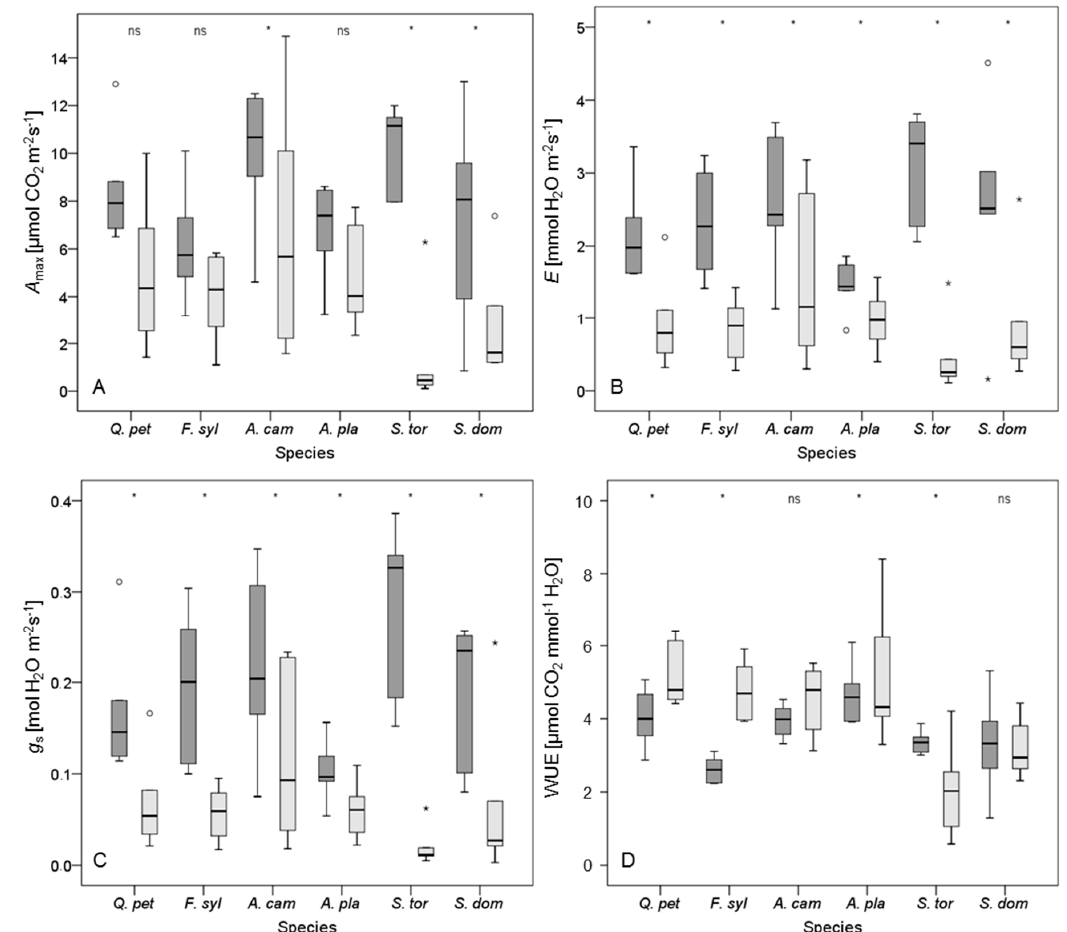
Figure 3. Box plots for ( A ) maximum photosynthetic rate ( A max ); ( B ) transpiration rate ( E ); ( C ) stomatal conductance to water vapor ( g s ); and ( D ) water use efficiency (WUE ( A max / E )) for plants of the control (dark grey box plots) and the dry group (light grey box plots) after 32 days without irrigation. Species are abbreviated as Q. pet ( Quercus petraea ), F. syl ( Fagus sylvatica ), A. cam ( Acer campestre ), A. pla ( A. platanoides ), S. tor ( Sorbus torminalis ), and S. dom ( S. domestica ). Empty circles denote outliers (defined as 1.5–3 times of box height), small stars represent extreme values (defined as more than 3 times of box height). Asterisks indicate significant differences between irrigation regimes ( p < 0.05); ‘ns’ indicates no significant difference. n = 12 per tree